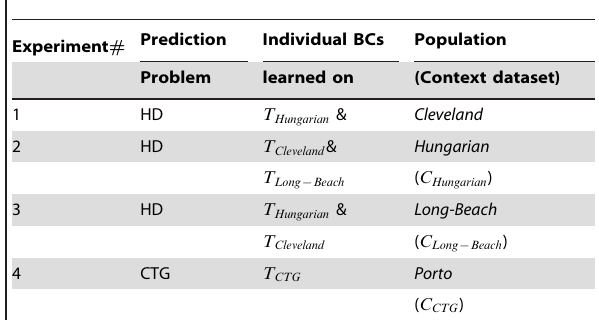
Table 5. Experiments description.